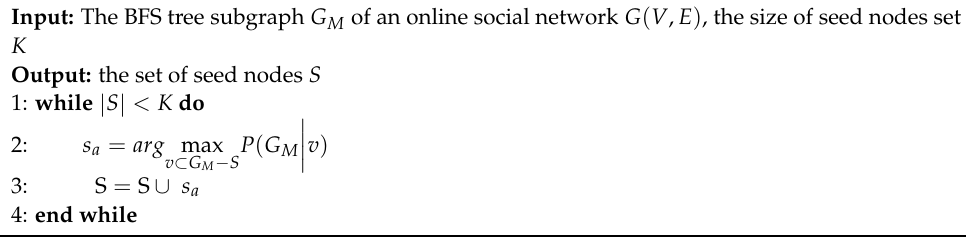
Algorithm 2 Construction of seed set based on greedy strategy